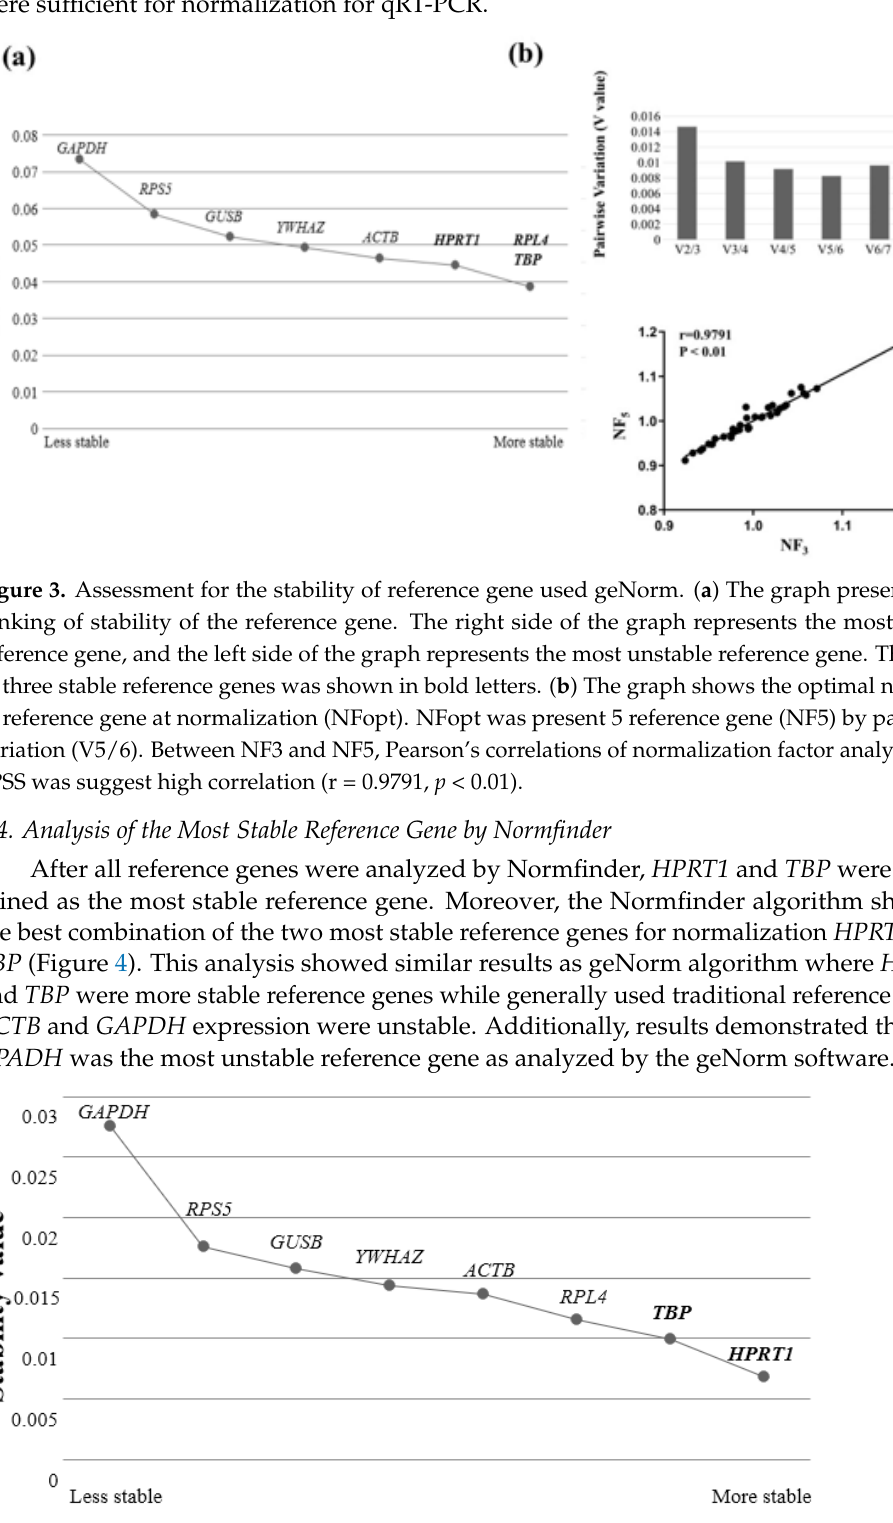
Figure 4. Analysis of reference gene stability used Normfinder. The most stable reference gene ranked on the right side of the graph and the most unstable reference gene ranked on the left side of the graph. The best combination of two reference genes was shown in bold letters.